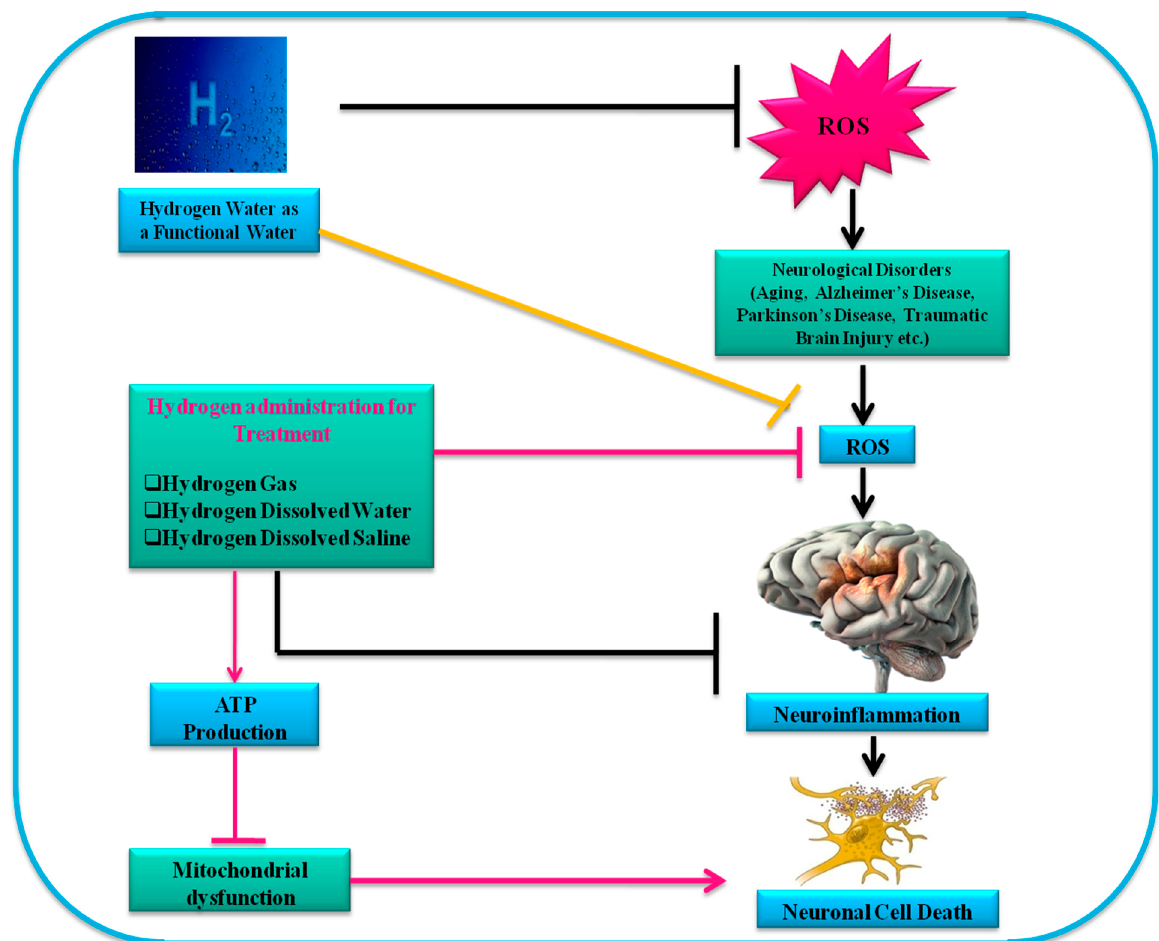
Figure 1. Beneficial effects of H 2 on different acute neuronal conditions.